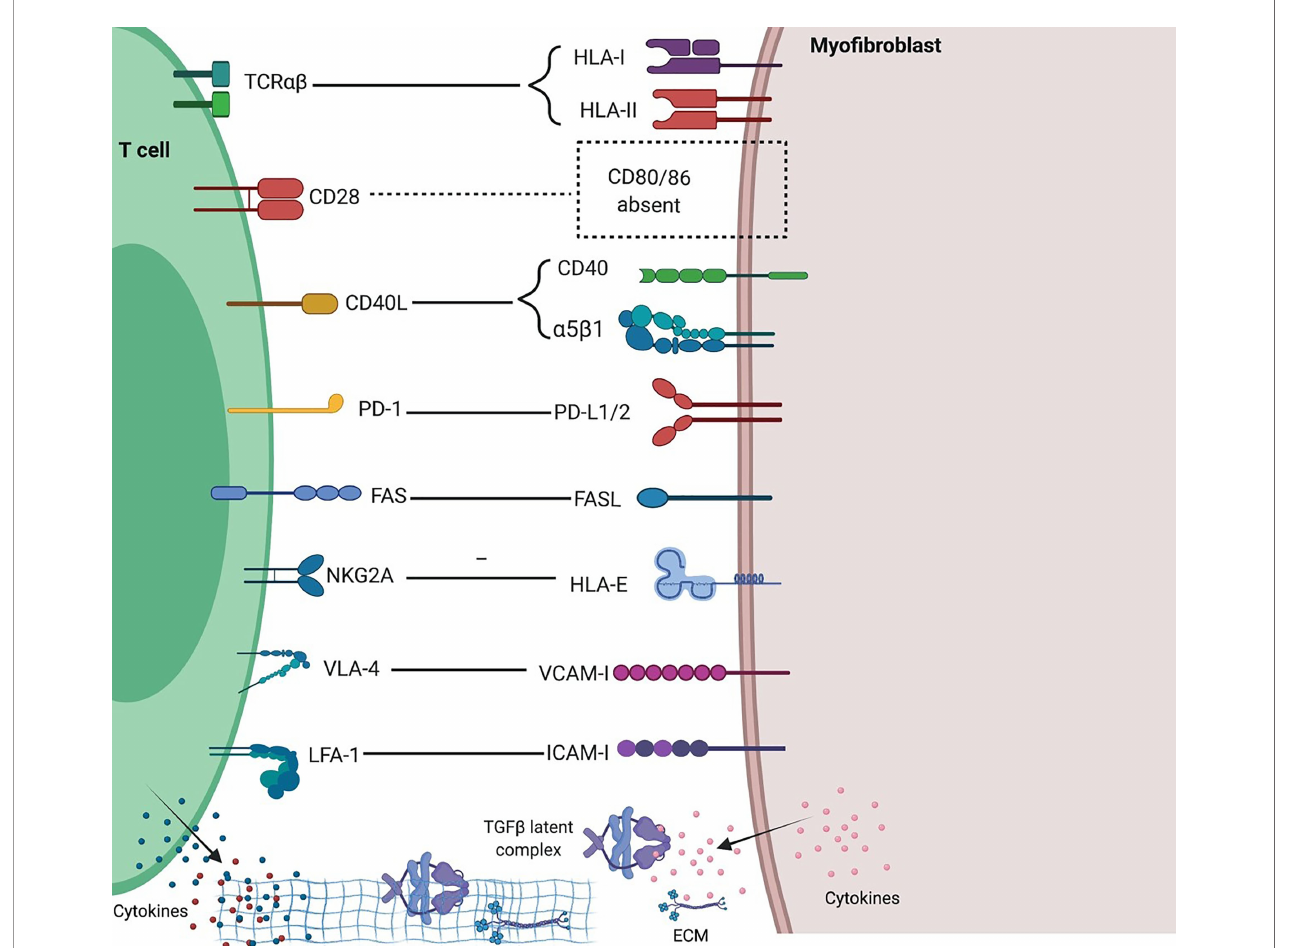
FIGURE 3 | Interactions between T cells and fi broblasts and their implications in fi brosing ILDs. Distinct molecular interactions and reciprocal intracellular signaling exist between heterogenous T cells and fi broblasts in different tissue and immune contexts. Generally, fi broblasts inhibit T cell activation and proliferation due to a lack of potent costimulation and presence of multiple inhibitory signals, and in in fl ammatory settings such as ILDs, mediate Th1 to Th2 and iTreg to Th17 conversions, thus favoring fi brosis and in fl ammation. Created with